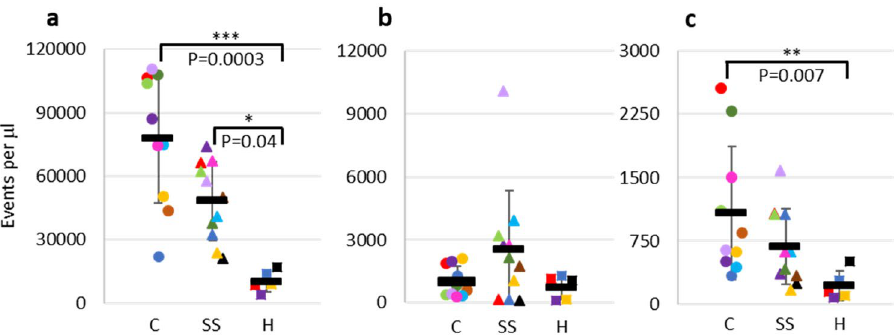
Figure 2. Analysis of RCDP in PFP from SCD patients in steady state and in crisis by imaging flow cytometry. PFP from SCD patients in steady state and in crisis and health individuals was stained with BRIC256- Alexa Fluor 647 and BRIC163-Alexa Fluor 488, as described in the materials and methods. Numbers of ( a ) BRIC256 +ve /163 −ve , ( b ) BRIC256 −ve /163 +ve and ( c ) dual BRIC256 +ve /163 +ve events found in SCD plasma from patients in crisis (circle, n = 10), steady state (triangle, n = 11) and from healthy individuals (square, n = 5). Each data point represents one sample with the black bars showing the mean number of events in each cohort